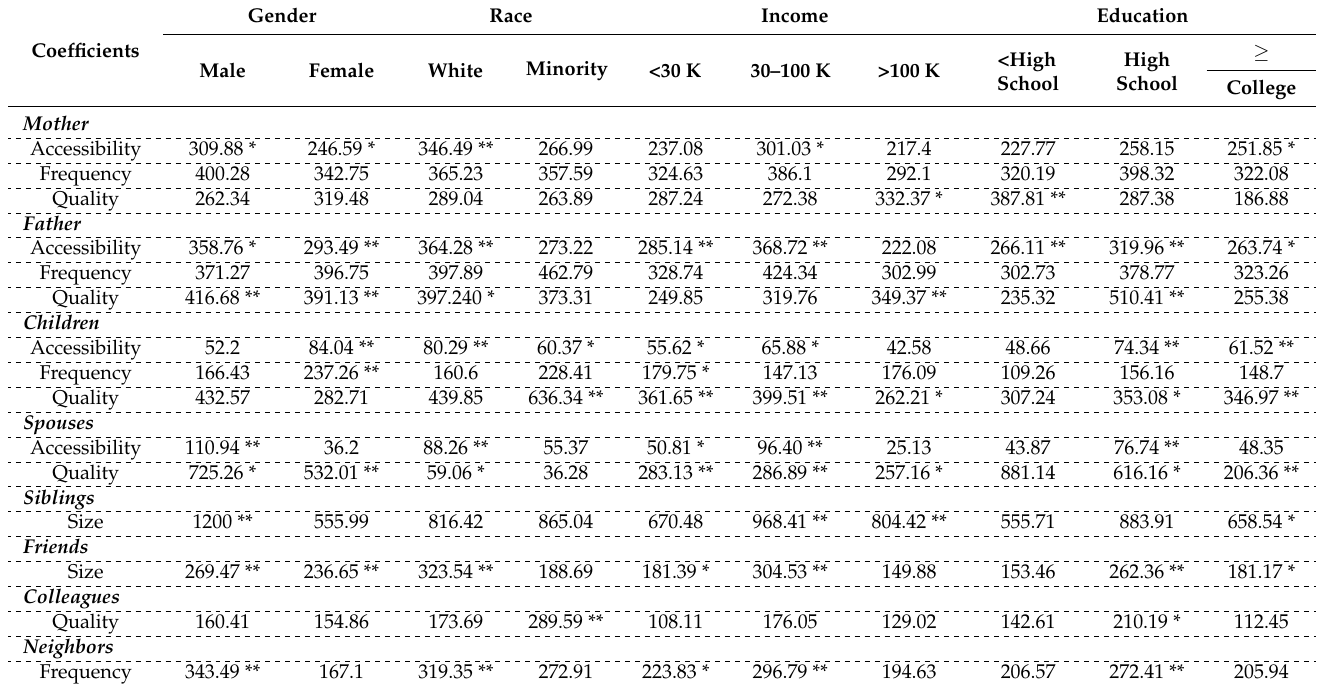
Table 6. The chi-square results of social networks and physical activity in relation to the socio- demographic